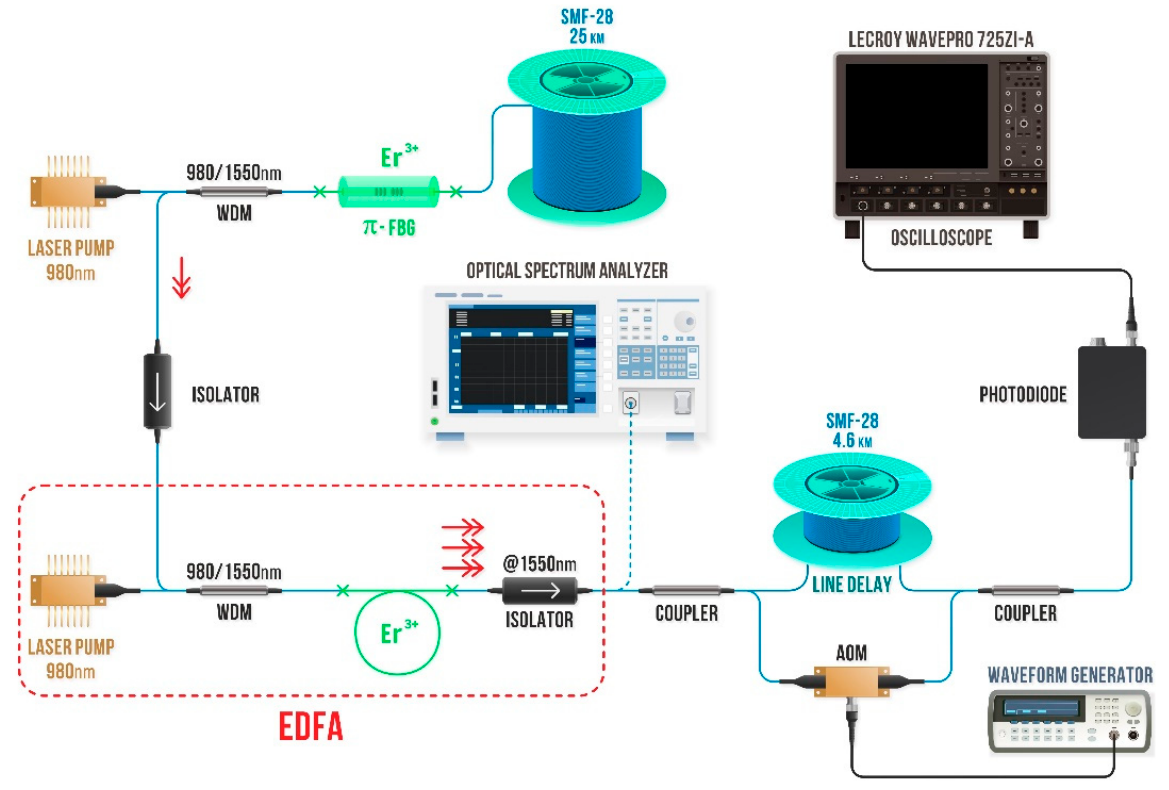
Figure 2. Scheme of the DFB and hybrid laser configurations and related measuring equipment.